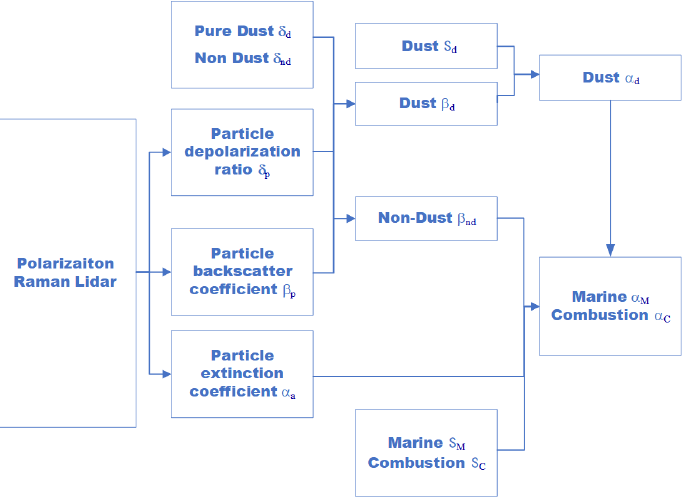
Figure 2. An overview of the polarization Raman lidar data analysis for aerosol type